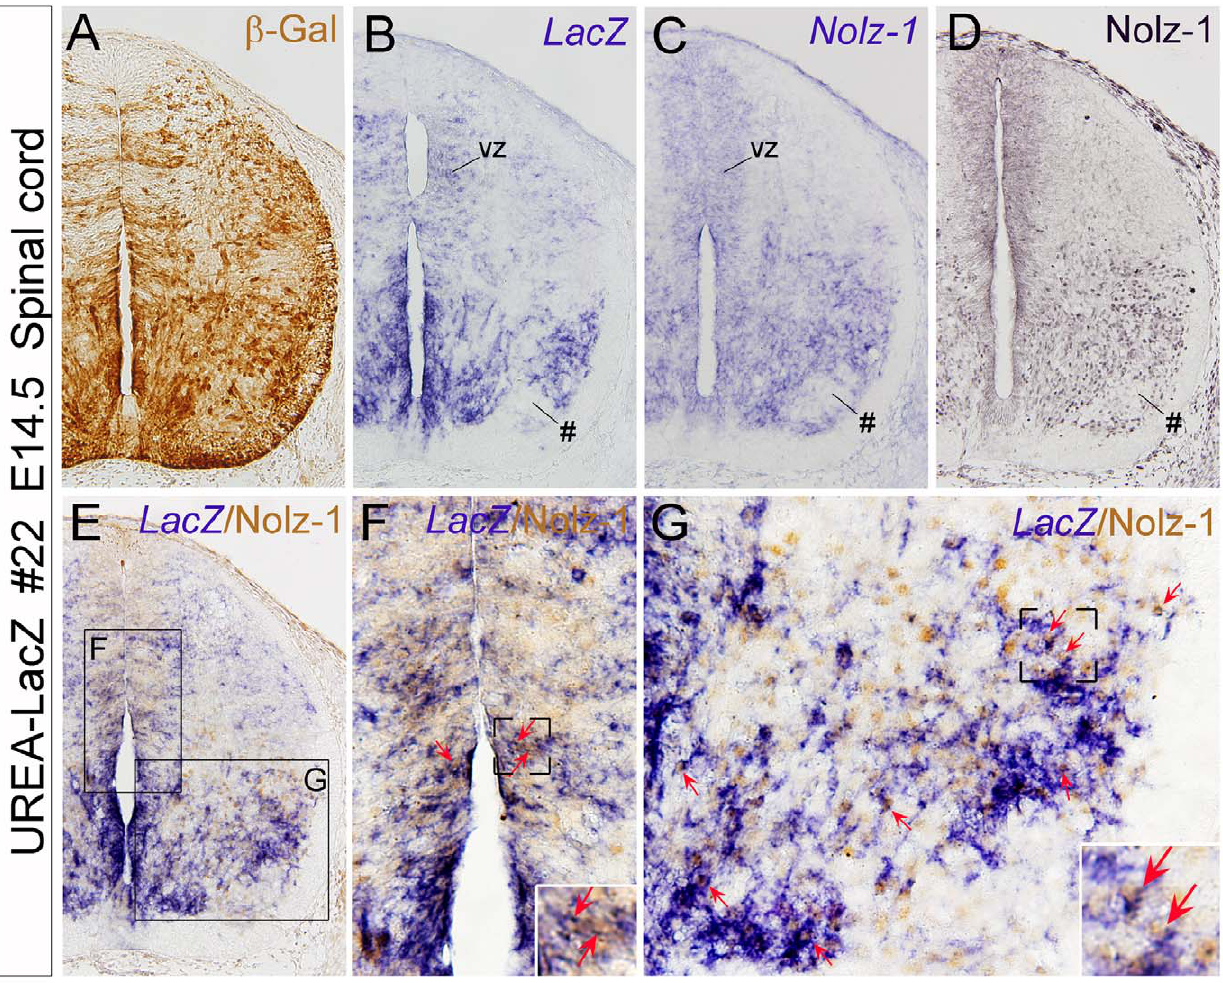
Figure 3. Detection of LacZ and Nolz-1 co-expressing cells in spinal cord of UREA-LacZ embryos. A–D: Adjacent transverse sections of E14.5 spinal cord of line # 22 UREA-LacZ embryos at the lumbar level. Expression patterns of b -gal protein (A) and LacZ mRNA (B) are similarly except that, in addition to soma, b -gal immunoreactivity is present in neurites, which results in broad expression pattern (A). Expression of Nolz-1 at mRNA (C) and protein (D) levels are consistently detected in selective domains of spinal cord, including in the ventricular zone (vz) of dorsal and ventral spinal cord and medial and lateral regions of the ventral spinal cord where LacZ gene (B) is also expressed. A LacZ and Nolz-1 -negative domain is present in the ventrolateral part of spinal cord (see # in B–D). E–G: Double labeling of LacZ mRNA and Nolz-1 protein identifies many co-expressing cells (red arrows) in the ventricular zone (F) and in the medial and lateral domains of basal plate of spinal cord (G ). The boxed regions in E are shown at high magnification in F and G. dispersed dorsally as development progressed (Figure 5E and data not shown). Most X-gal-positive cortical cells co-expressing Nolz-1 were observed at the middle and caudal levels (double arrows, Figure 5H, I) with few double positive cells present at the rostral level.